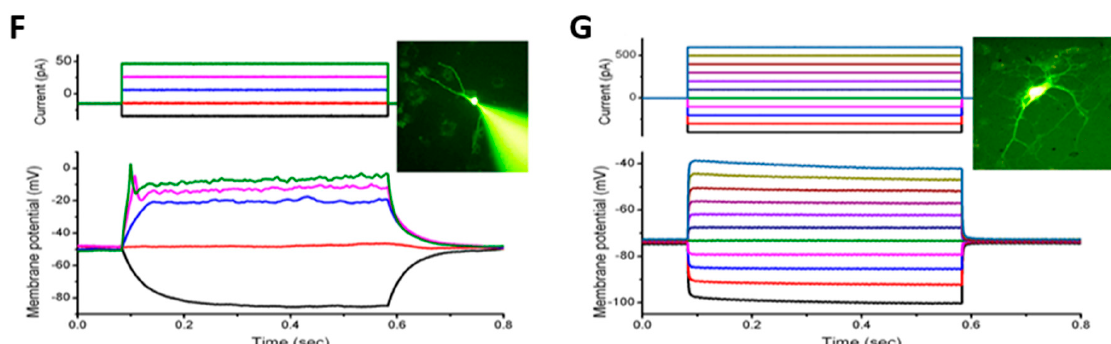
Figure 5. Assessment of neuronal electrophysiological activity in differentiated neurons. rNSCs were seeded onto laminin- coated AuNC-aECMs, and after 2 days, cells were treated with indicated laser irradiation parameters (0.5–5.0 W/cm 2 for 1–5 min). After 14–16 days, cells were analyzed with the patch-clamp recordings ( A – G ). The resting membrane, input resistance, and spike amplitude were plotted for each coverslip ( A ). Cells that were filled with the Lucifer Yellow dye indicated morphological features post the patch-clamp recordings ( B – D ). ( B ) showed cells having a simple morphological structure with one identifiable fine axon (red arrow). ( C ) showed single cells having extensive dendrites in all direction. ( D ) showed that cells were connected to adjacent cells and a time-dependent filling of the neighboring cell. Correlation between electrophysiological parameters and representative electrophysiological data ( E ). A linear regression fit was performed among the different electrophysiological parameters: membrane potential, input resistance and spikelet amplitude. Note that a value of zero for the spikelet amplitude indicates that no spikelet could be evoked by member depolarization using positive current injection. ( F and G ) are representative voltage traces from an excitable cell ( F ) and a non-excitable cell ( G ) in response to injecting of square positive current pulses of varying amplitudes. Prob > F is a p-value for F-test, which is a probability with a value ranging from 0 to 1.